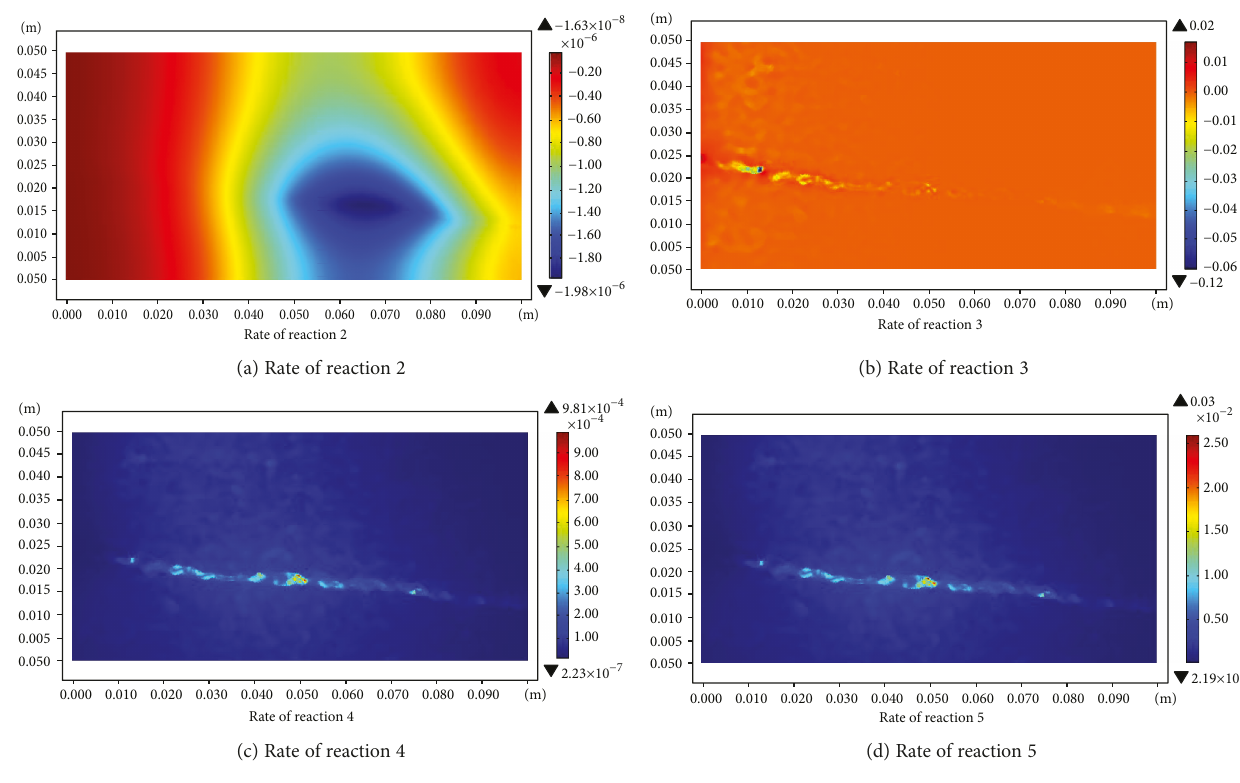
Figure 15: Rates of di ff erent chemical reactions ( t = 2000 s).